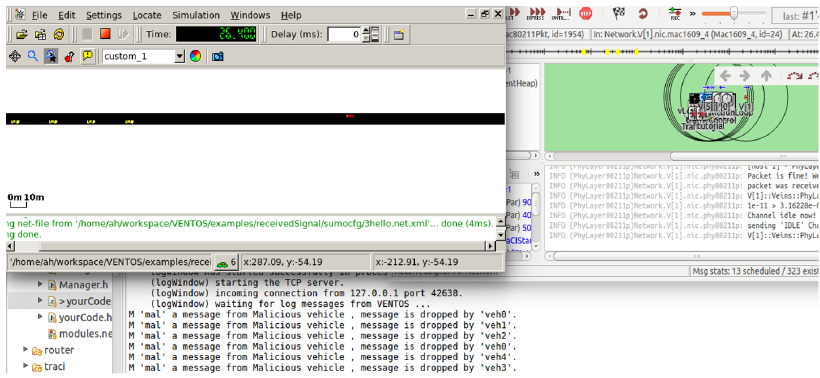
Fig. 5. Scenario 4: Vehicles Dropping Messages from Malicious Vehicle